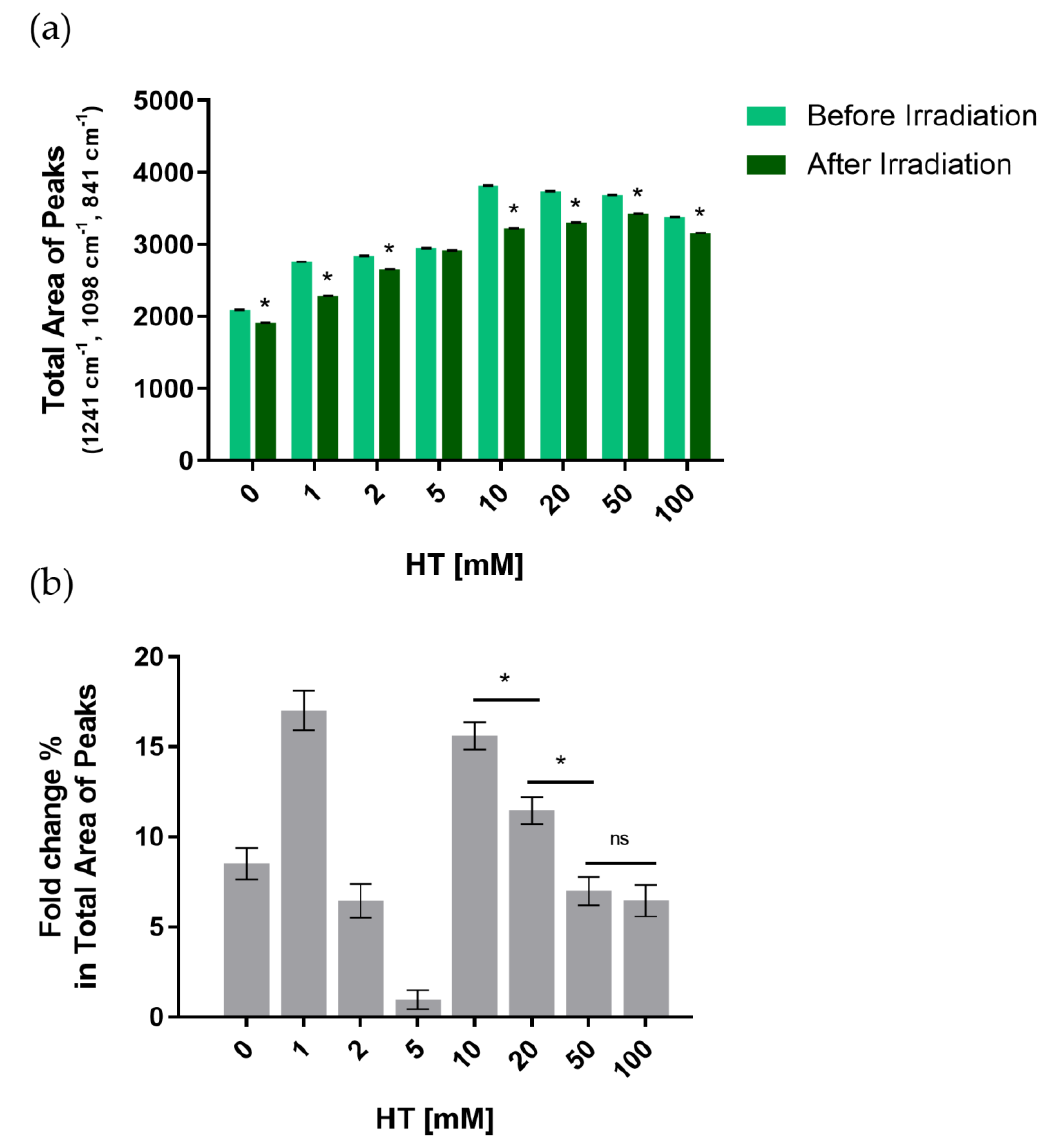
Figure 3. ( a ) Change in the areas of the peaks of interest (Total Area of Peaks is the sum of areas at 1241 cm –1 , 1908 cm –1 , and 841 cm –1 ) in non-irradiated and irradiated citrate buffer-based PEO hydrogels when increasing HT concentration; * p < 1 × 10 − 4 vs. non-irradiated samples with the same HT concentration; ( b ) Percentage of fold change in Total Area of Peaks (sum of areas at 1241 cm –1 , 1908 cm –1 , and 841 cm –1 ) between the non-irradiated and irradiated citrate buffer-based PEO hydrogels when increasing HT concentration. * p <